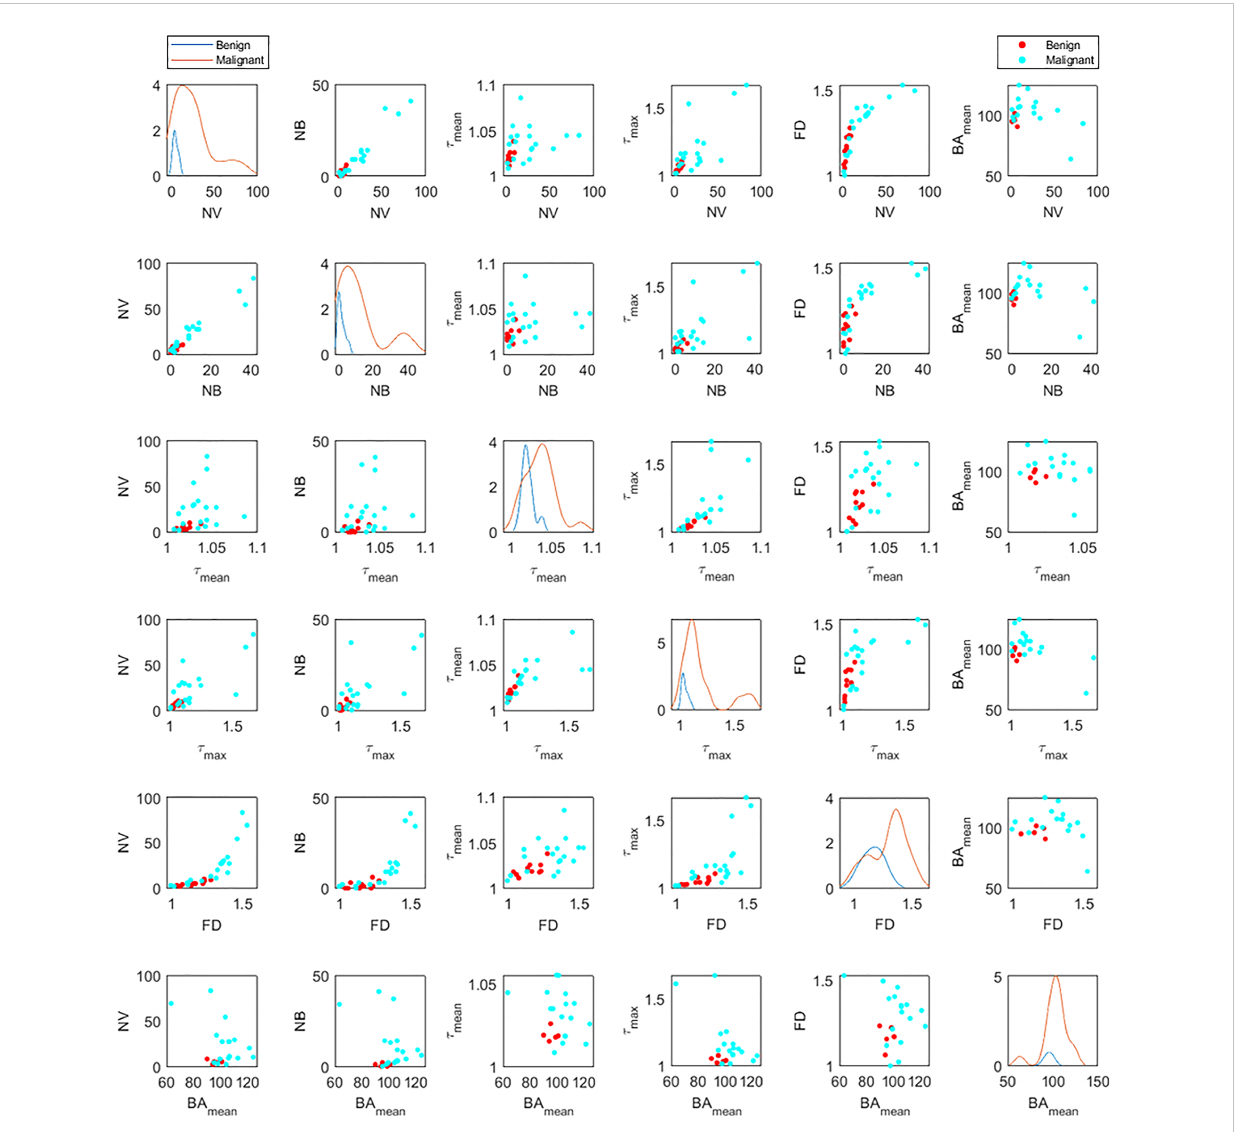
FIGURE 6 Distribution densities (diagonal) and bivariate scatterplots (off-diagonal) among statistically signi fi cant morphological variables for benign and malignant lesions. Variables include number of vessel segments ( NV ), number of branch points ( NB ), mean tortuosity ( t mean ), maximum tortuosity ( t max ), fractal dimension ( FD ), and mean of bifurcation angle ( BA mean ). For each distribution graph (diagonal fi gures), the orange line corresponds to the malignant lesions and the blue to the benign ones. In the off-diagonal scatterplots, the red dots correspond to the malignant lesions and the cyan to the benign